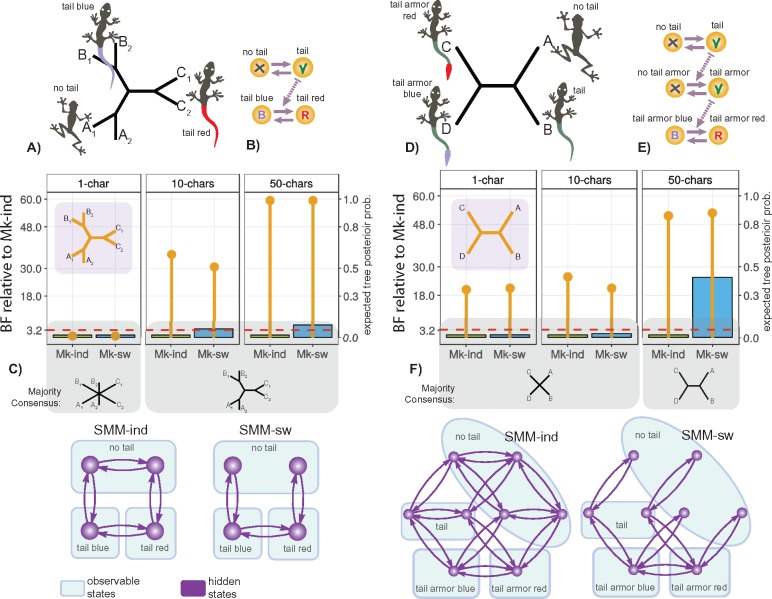
Model comparison for the tail problems. a–c) Tail color problem. d–f) Tail armor case. a d) Expected trees. b e) Graphs depicting anatomical dependencies between the traits. c f) Results of inference; Mk-ind and Mk-sw correspond to one parameter Mk-SMM-ind, Mk-SMM-sw respectively; for each model the column bar indicates the BF relative to the best-fitting Mk-ind model (left-side legend), while thin bar indicates the posterior probability of the expected tree (right-side legend); note that the higher BF values indicate worse model fit, the threshold of BF \documentclass[12pt]{minimal}
\usepackage{amsmath}
\usepackage{wasysym}
\usepackage{amsfonts}
\usepackage{amssymb}
\usepackage{amsbsy}
\usepackage{upgreek}
\usepackage{mathrsfs}
\setlength{\oddsidemargin}{-69pt}
\begin{document}
}{}$<$\end{document} 3.2 means that the two models yield similar fit. The graphs on the bottom show the topologies of SMM models used for the inference.